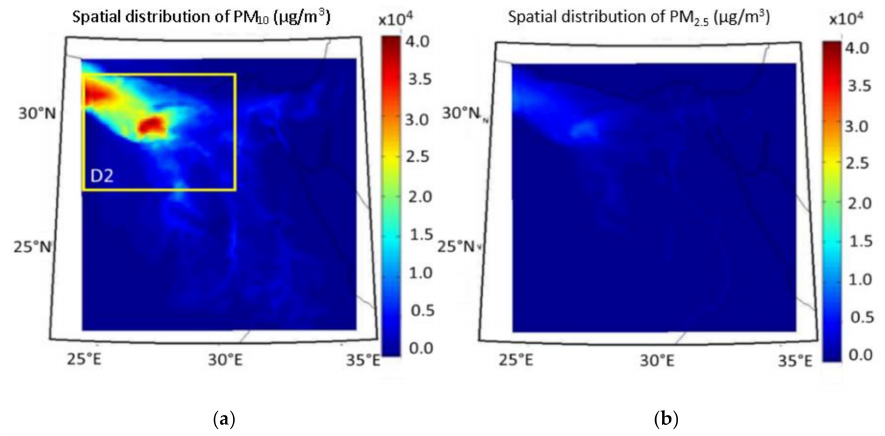
Figure 10. Spatial distribution of the PM 10 ( a ) and PM 2.5 ( b ) during the dust storm of 31 March 2013 from DS1 with coeff. 10.0. Domains D2 (the core of the dust storm) is marked. The color bar represents the particle density ( µ g/m 3 ) multiplied by 10 4 .